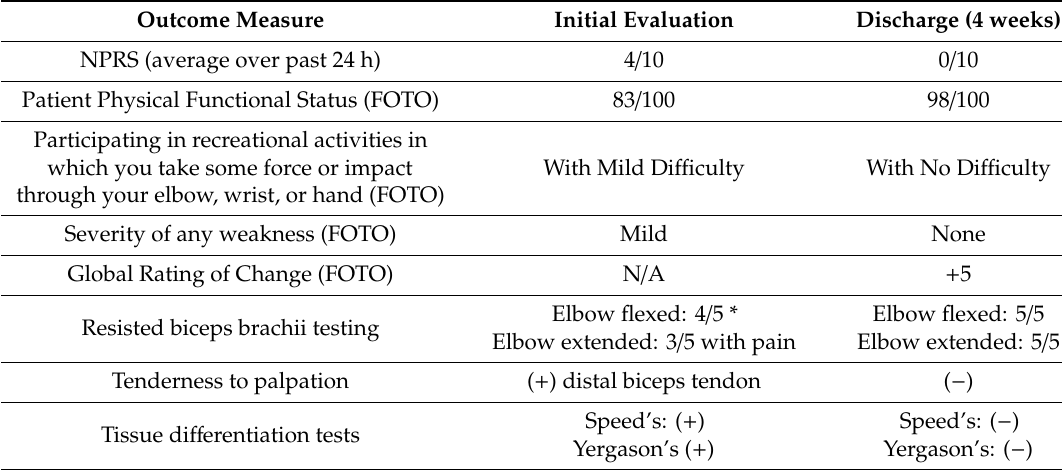
Table 3. Subjective and objective